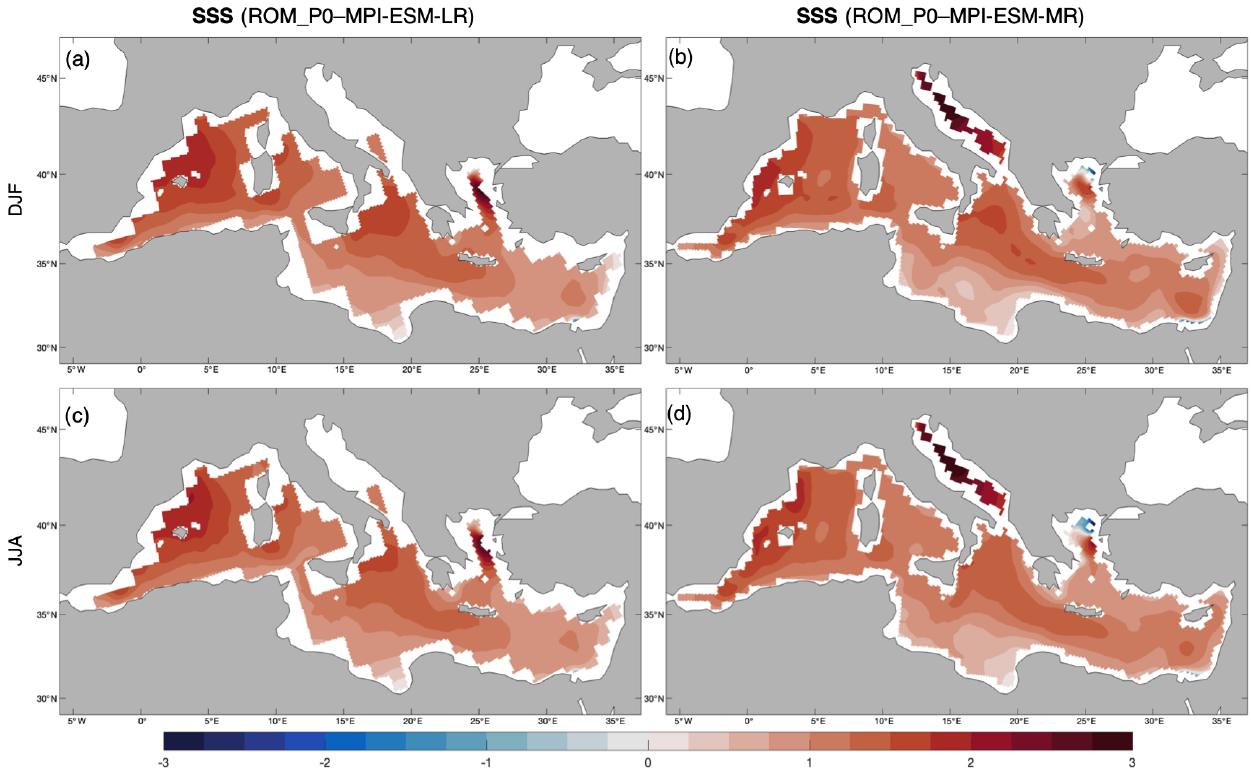
Figure 10. SSS (psu) differences between the ROM_P0 and MPI-ESM-LR (a, c) and MPI-ESM-MR (b, d ) in winter (DJF a, b ) and summer (JJA c, d ).